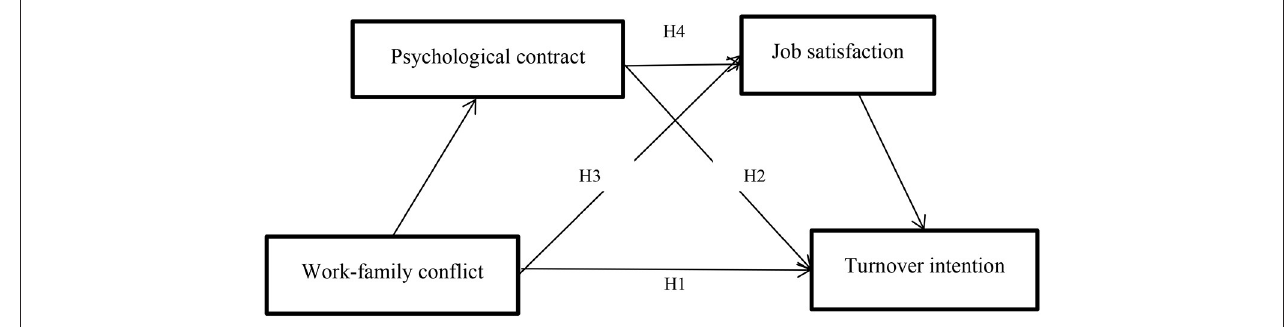
FIGURE 1 | Hypothesized